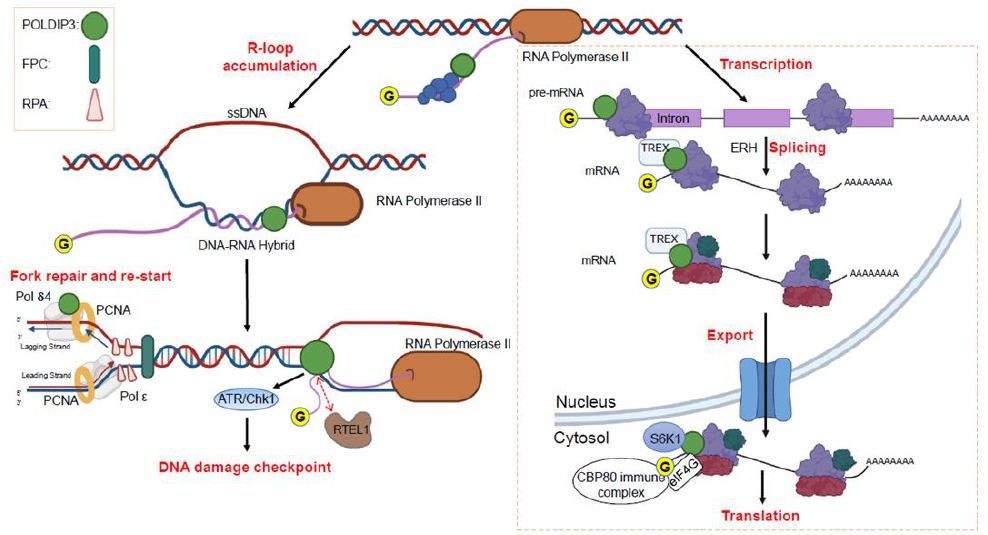
Figure 5. A model of how POLDIP3 orchestrates multiple biological processes related to RNA and DNA metabolism. FPC: fork protection complex that consists of Tipin, Timeless, Claspin and AND1. RPA: replication protein A that consists of RPA70, RPA34, and RPA14. TREX: transcription and export complex that consists of the THO complex and a group of accessory